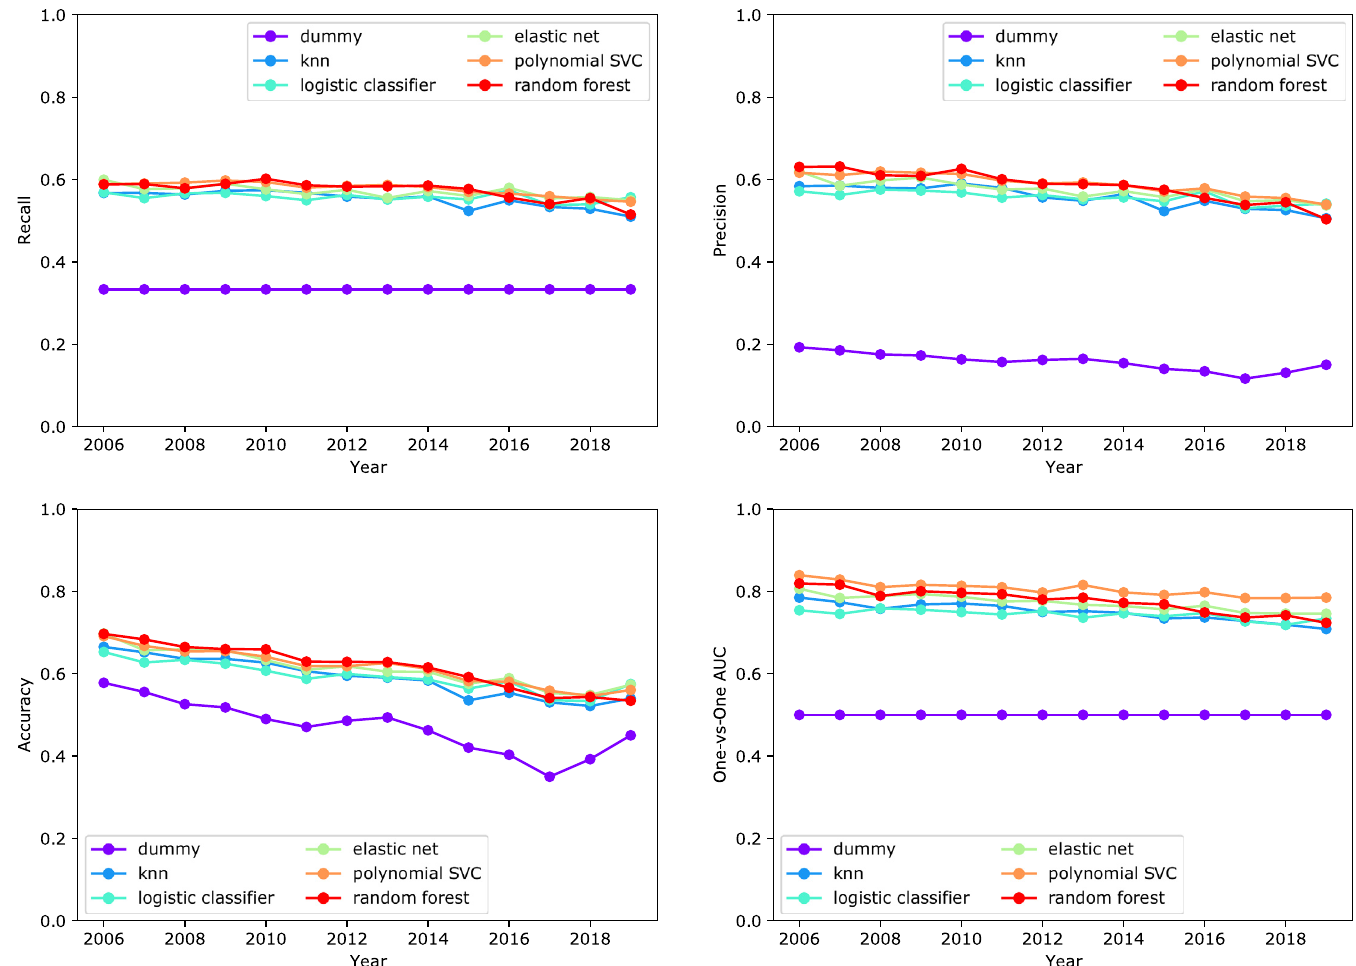
Fig 3. Predictive performance of models constructed with various classification methods using the complete set of 4,636 features. The predictive performance for the various classifiers is similar, and each outperforms the dummy classifier. Note: On most plots, the performance of the logistic classifier is not visible, since its performance is the same as the elastic